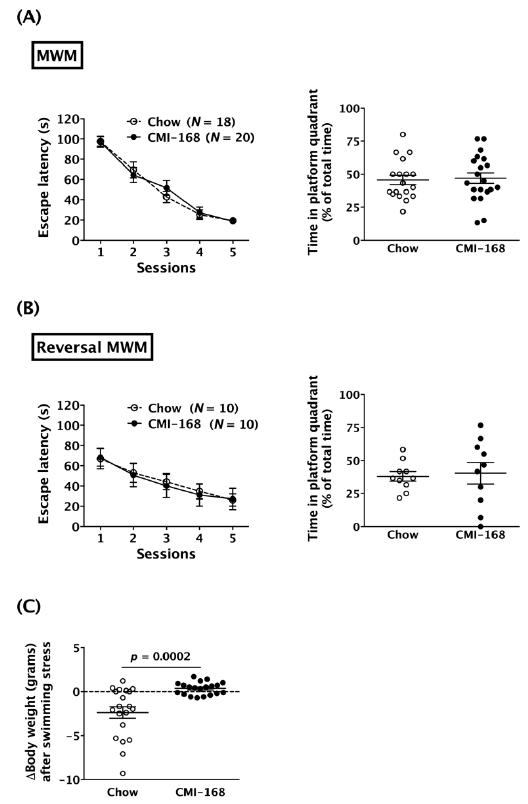
Figure 3. Effects of six-week CMI-168 dietary supplementation on the performances of the Morris water maze (MWM) and swimming stress-induced weight loss in mice. ( A ) Escape latencies during training sessions and the time spent in the platform quadrant in the probe test of the Chow and CMI-168 mice in the MWM. ( B ) Escape latencies during training sessions and the time spent in the platform quadrant in the probe test of the Chow and CMI-168 mice in the reversal MWM. ( C ) Swimming stress-induced body weight changes of the Chow and CMI-168 mice.